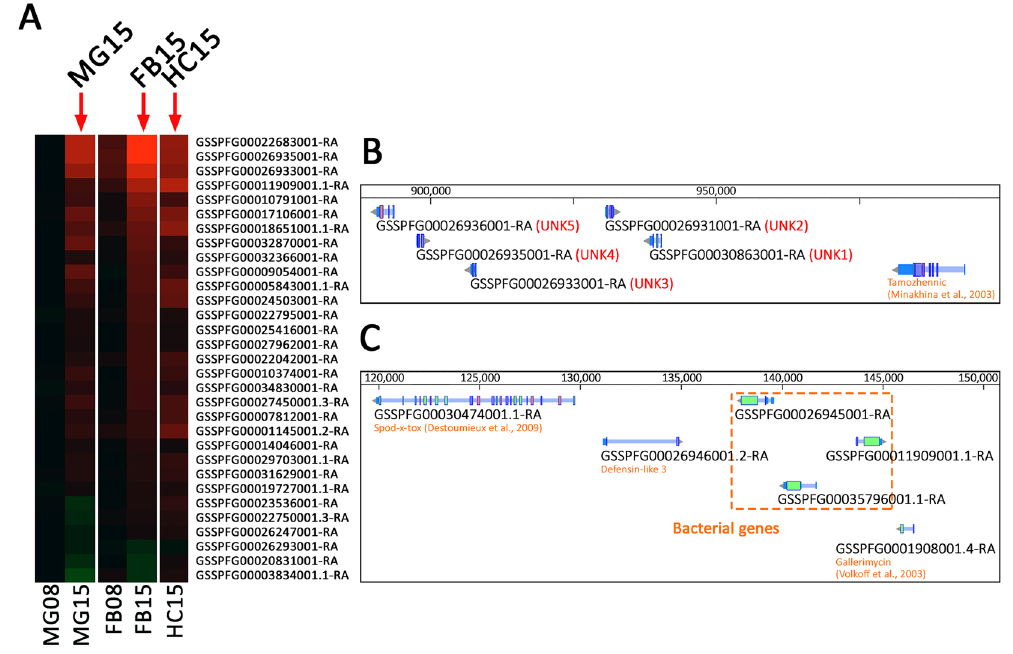
Figure 5. Expression for the 31 genes common to midgut, the fat body and the hemocytes. ( A ) As in Figs 2 and 3, heatmap of differential expression for the 31 genes common to MG15, FB15 and HC15. ( B ) WebApollo viewer showing the annotation of unknown genes in cluster on the scaffold_520. ( C ) WebApollo viewer showing the annotation of clustered genes of bacterial origin within a defensin